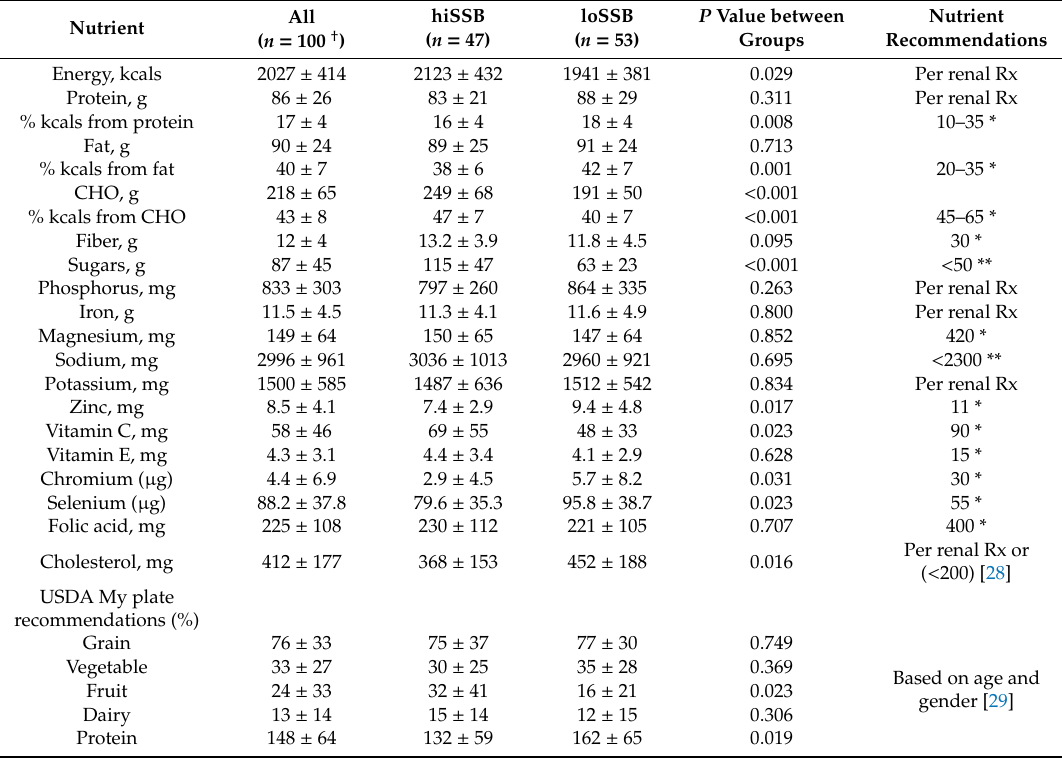
Table 3. Mean daily nutrient intake according to diet